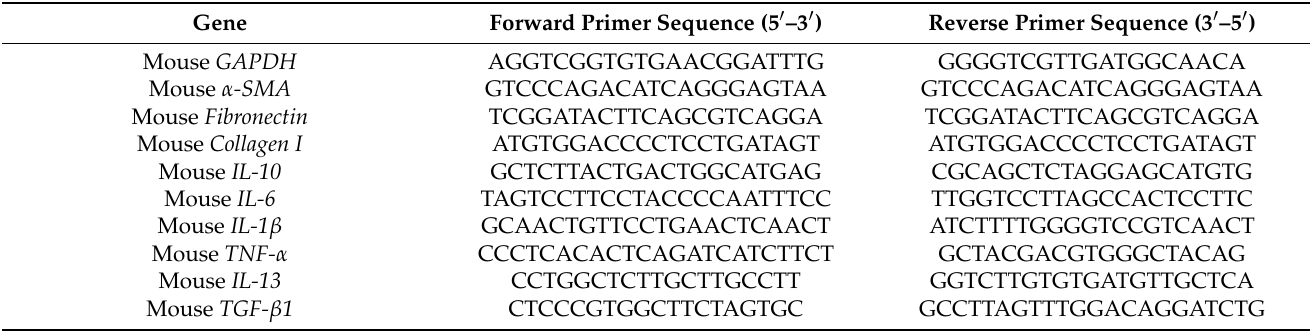
Table 1. Primers sequences for real-time